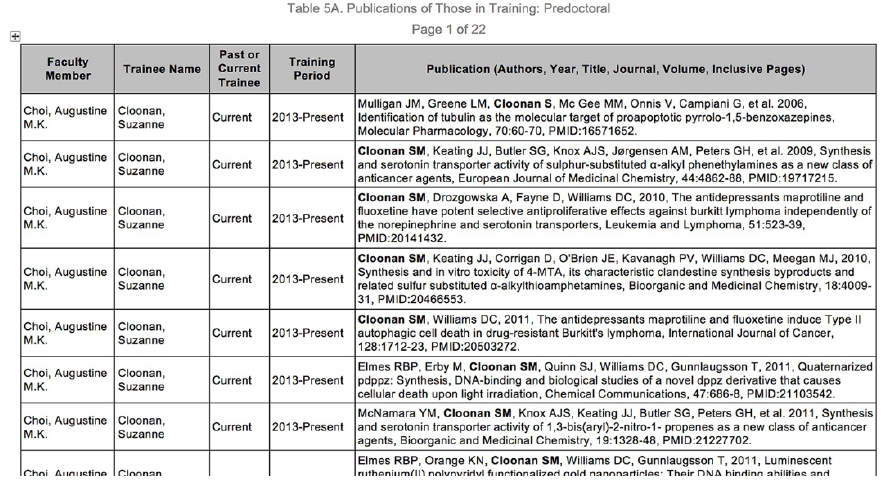
Figure 1 Sample output of Table 5A for T32